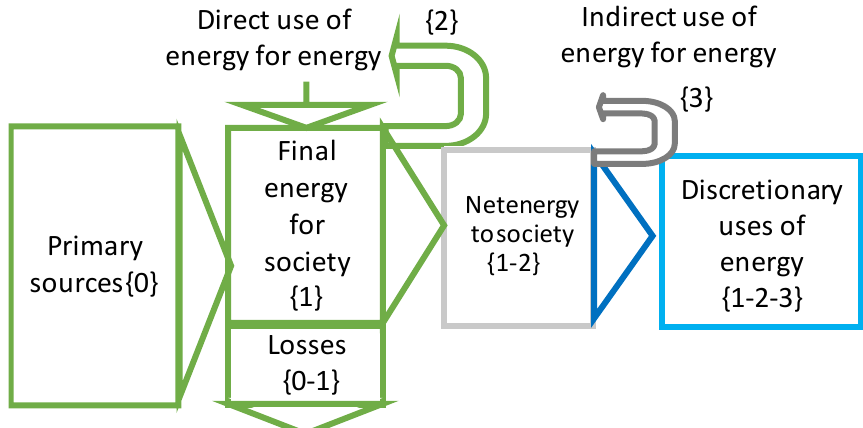
Figure 1. Energy flux from primary material sources of energy {0} to discretionary uses of energy. EROI st = ({0}/g)/{2} (EROI standard, being “g“ a correction factor to convert “primary” to final). EROI final = {1}/{2′} (EROI final, where {2′} includes the direct use of energy to bring it to the user) and EROI ext = {1}/({2’+3}) (EROI extended, all the terms at final and user phase). Note that the relevant energy for a society is the blue box (discretionary uses of energy), but primary sources of energy, and the other boxes, are relevant for environment issues because they are always taken / used in the biosphere (see reference [3] for more details).